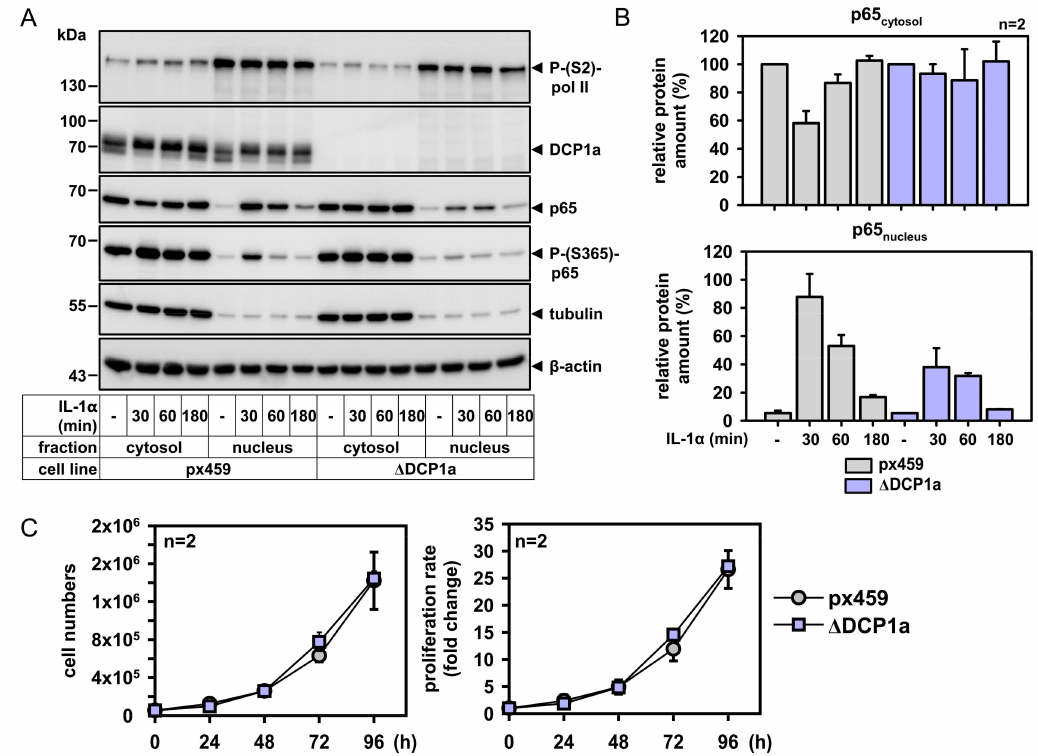
Figure 7. DCP1a is required for e ffi cient nuclear translocation of p65 NF- κ B. ( A ) HeLa cell lines with CRISPR / Cas9-mediated suppression of DCP1a ( ∆ DCP1a) or cells stably transfected with the control vector (px459) were incubated for the indicated times with IL-1 α (10 ng / mL) or were left untreated. Cytosolic and nuclear extracts were prepared and the presence of p65 and DCP1a proteins was examined by immunoblotting. Anti-tubulin, β -actin, and P(S2)-RNA polymerase II antibodies were used to control for purity of the fractions and for equal loading. Shown is one out of two independent experiments with compatible results. ( B ) Shows relative quantification of mean p65 protein amounts +/ − SD from two independent experiments. ( C ) The same cells were seeded at two di ff erent densities and cell numbers were assessed at the indicated time points. The graphs show cell numbers and corresponding fold